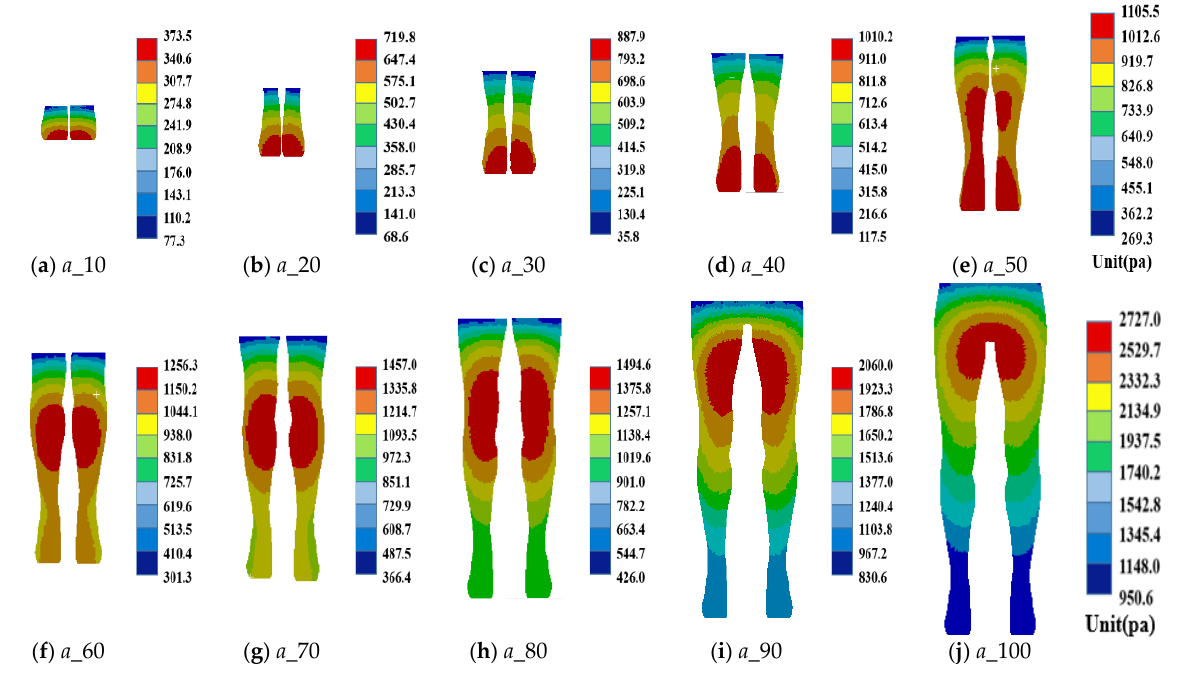
Figure 19. Hydrodynamic pressure of adult walking at a minimum safe speed at different flood heights.